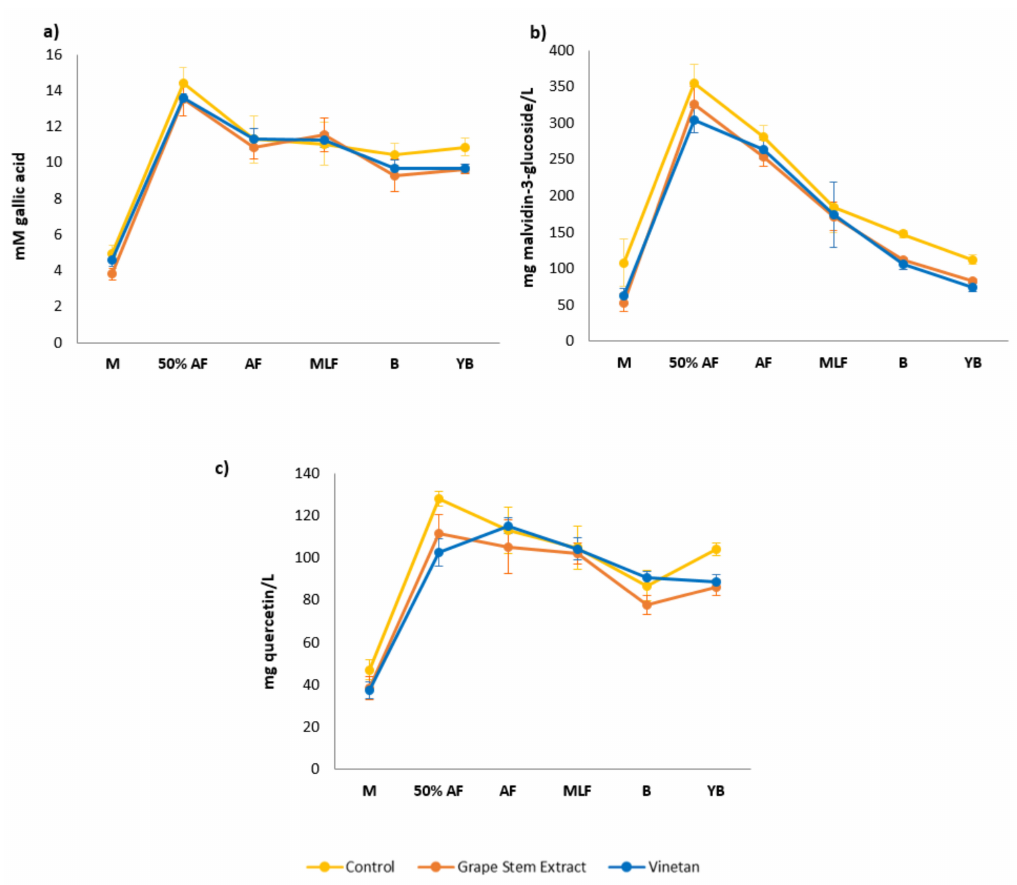
Figure 1. Concentration of ( a ) total phenolic content (mM gallic acid), ( b ) total anthocyanins (mg malvidin-3-glucoside / L), and ( c ) total flavonoids (mg quercetin / L), obtained by spectrophotometric methods. M = Must; 50% AF = Half Alcoholic Fermentation; AF = Final Alcoholic Fermentation; MLF = Final Malolactic Fermentation; B = bottling; and YB = one year after bottling (Mean ± SD, n =